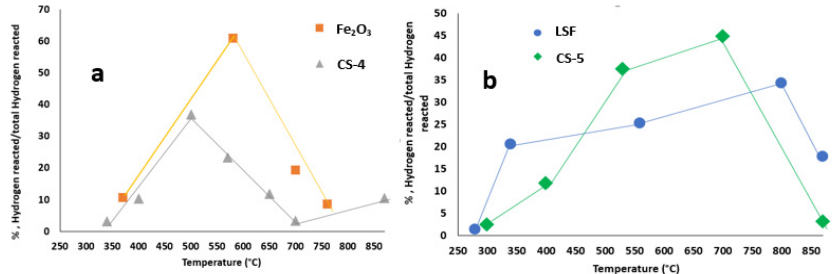
Figure 10. H 2 consumption percentage as a function of temperature in H 2 -TPR: ( a ) - Fe 2 O 3 and CS-4 materials; ( b ) LSF and CS-5 materials.